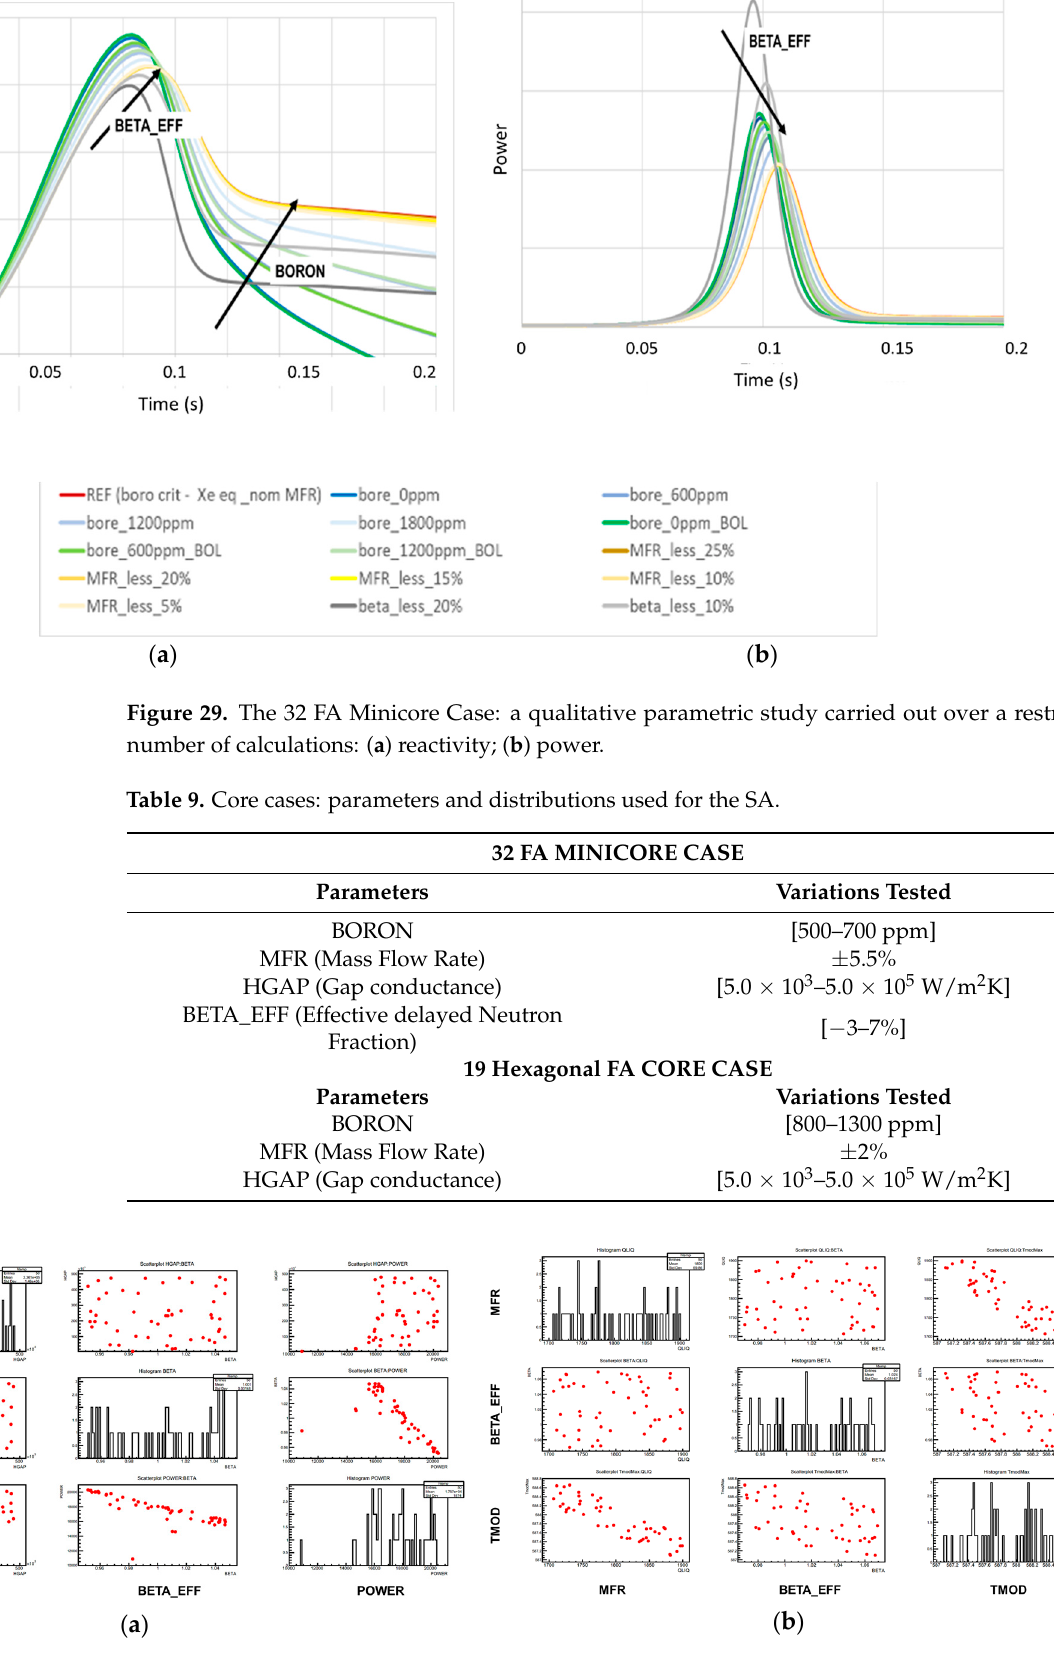
Figure 30. 32 FA Minicore Case: Pairs plot (MFR, HGAP, BETA_EFF): ( a ) power; ( b ) moderator temperature.